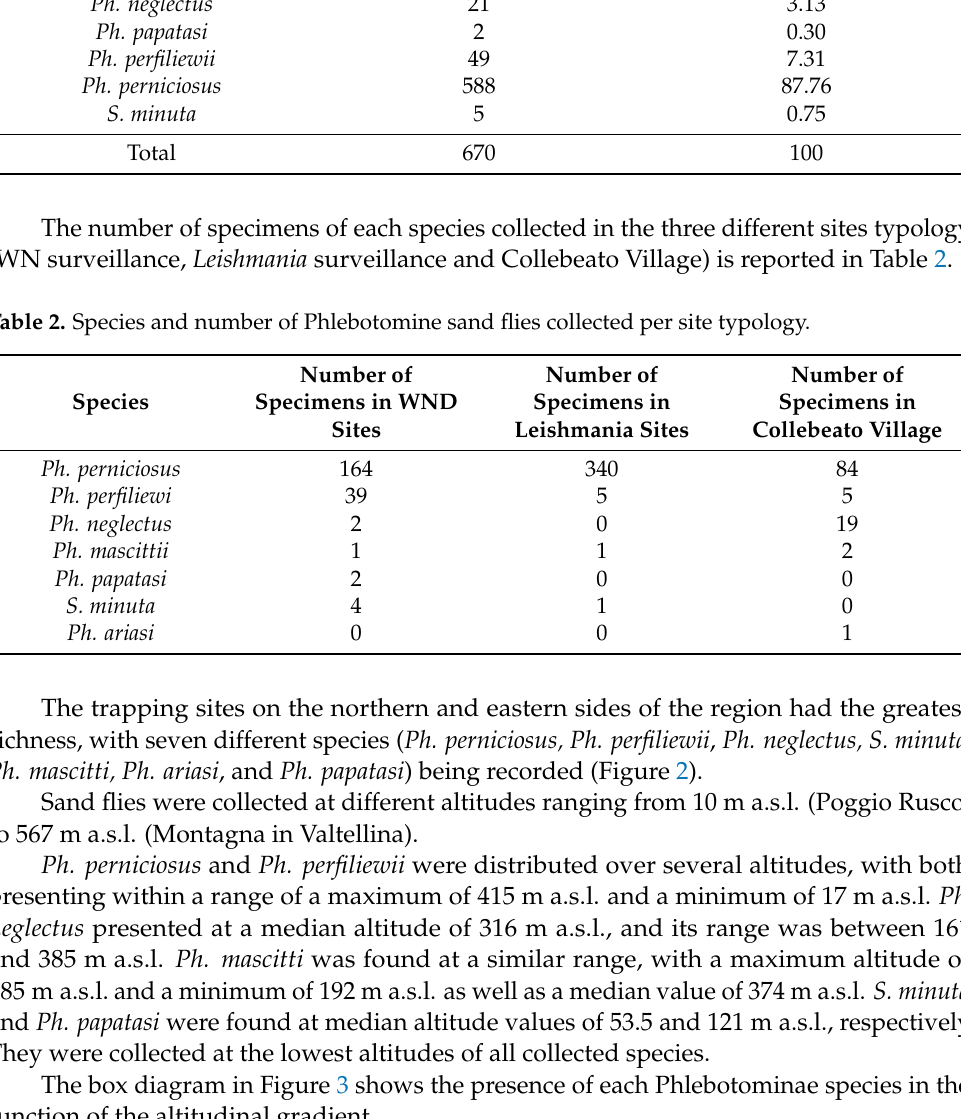
Table 1. Sand fly species identified in Lombardy from 1 June to 1 October 2021. Number of Specimens % Species Identified Ph. ariasi 1 0.15 Ph. mascitti 4 0.60 Ph. neglectus 21 3.13 Ph. papatasi 2 0.30 Ph. perfiliewii 49 7.31 Ph. perniciosus 588 87.76 S. minuta 5 0.75 Total 670 100